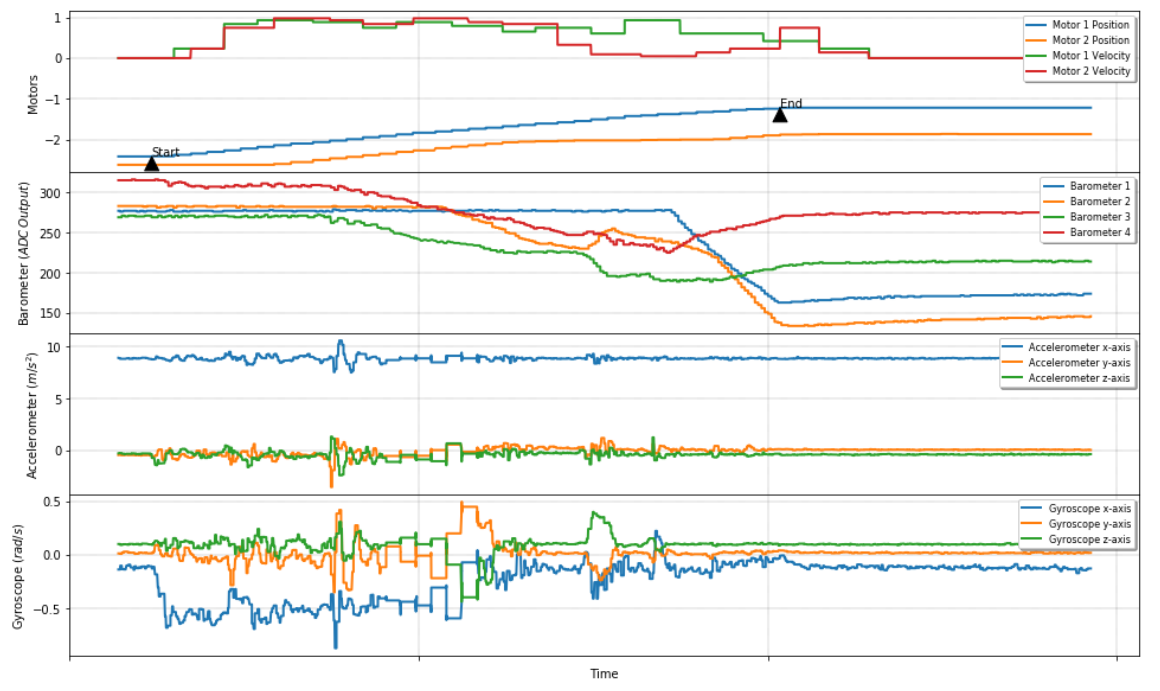
Figure 12. Actuator velocities during a stable grasping. Barometers, accelerometers, and gyroscopes values varying until stable grasp, followed by stabilization of sensor